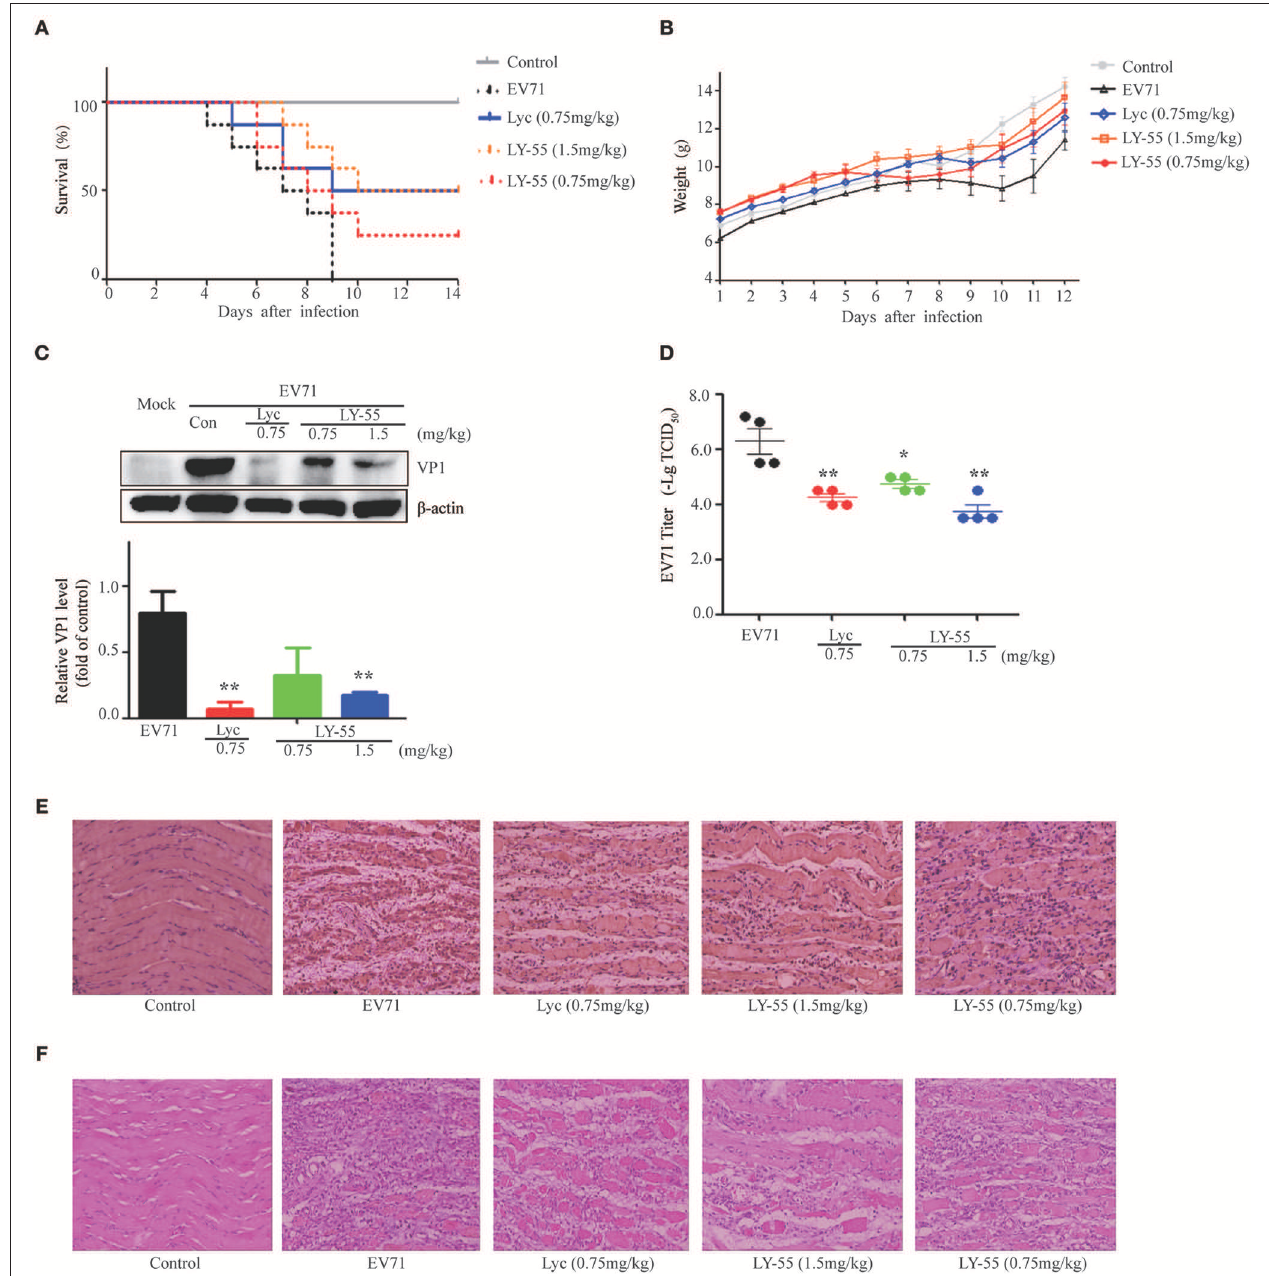
FIGURE 5 | LY-55 treatment reduced the mortality of mice upon lethal EV71 challenge and reduced the EV71 replication post sub-lethal dose EV71 challenge in vivo . (A) 12-day ICR mice were infected with 10 LD 50 of EV71-mouse adapted strain (EV71-H-MA), followed by administration of LY-55 and lycorine once a day at the indicated doses. Mice survival was observed for 14 days. (B–E) 12-day ICR mice were infected with 1 LD 50 of EV71-mouse adapted strain (EV71-H-MA), followed by LY-55 and lycorine administration once a day at the indicated doses. Eight mice enrolled in each group were intraperitoneally injected with LY-55 or lycorine for 7 days consecutively and weighed daily for 12 days. (B) Eight mice enrolled in each group were dissected at 5 dpi. Muscle tissues prepared from the four mice were used for viral protein expression and viral titer assays. Muscle tissues prepared from another four mice were applied in pathological and IHC analyses. The expression levels of VP1 protein in the muscles were determined by using Western blot analysis at 5 dpi ( n = 4) (C) . Vero cells were infected with a challenge of the diluted muscle homogenates at 5 dpi, and the viral titers were determined by –Log 10 TCID 50 ( n = 4) (D) . The muscle tissue sections prepared from mice at 5 dpi were stained with EV71 VP1 antibody (E) and H&E (F) . Each value represents mean ± SD. * P < 0.05, ** P < 0.01, vs. EV71-infected mice treated with water.